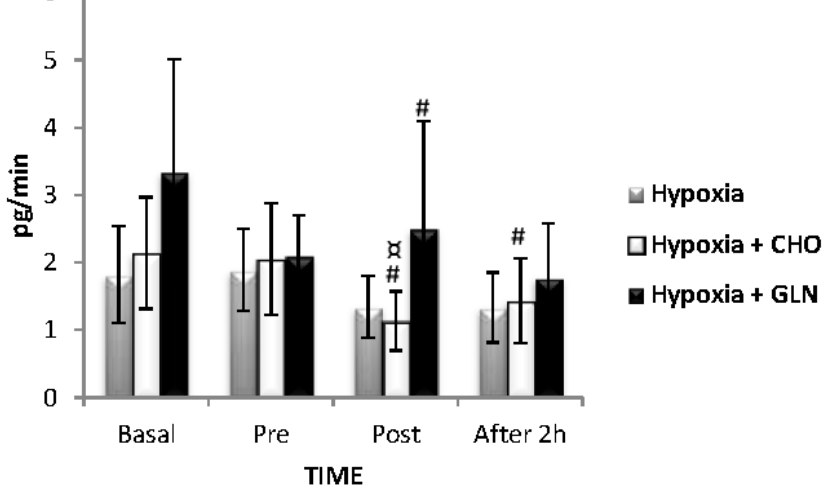
Figure 5. The results of tumor necrosis factor (TNF)- α secretory (pg/min) was described by mean ± Standard Error (SE). The interaction of group versus time was analyzed by Analysis of Variance (ANOVA) for repeated measures followed by post hoc of Tukey test. The level of significance was set at p < 0.05. n = 15 volunteers. # Different in relation to Basal. ¤ Statistically significant in relation to pre-exercise. Hypoxia + CHO = Hypoxia + carbohydrate and hypoxia + GLN = hypoxia + glutamine.